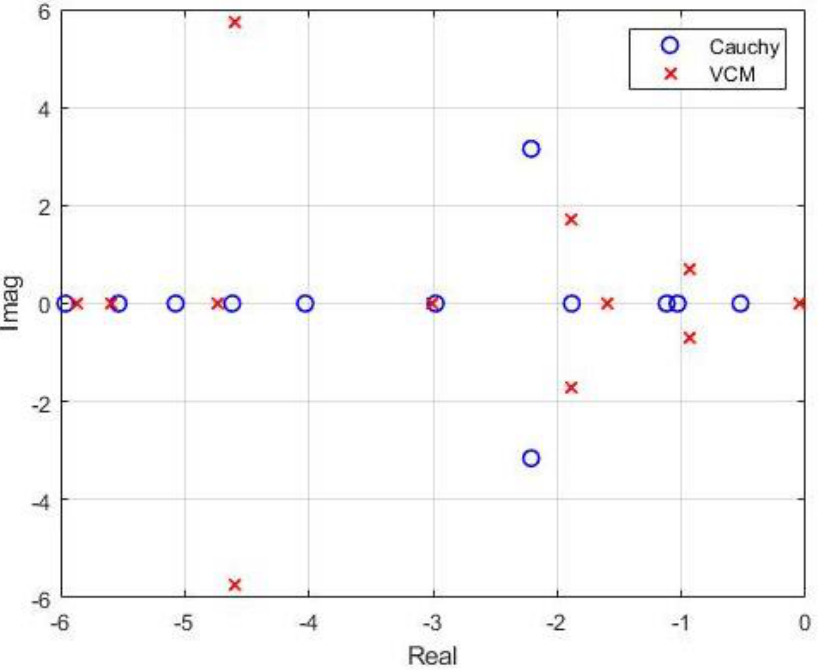
Figure 12. CNRs calculated with both the Cauchy and VCM methods using the frequency response of an electric metal detonator for IEDs in